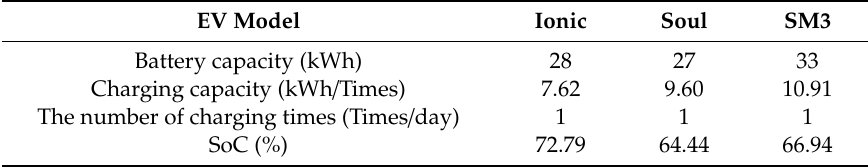
Table 14. The SoC of “Whenever possible” type